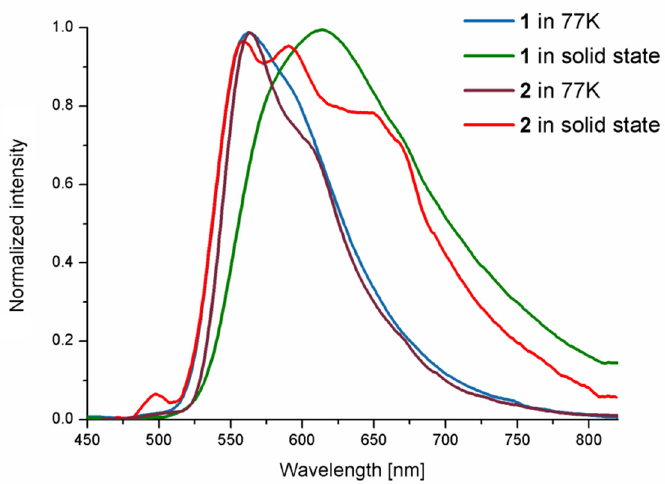
Figure 5. Normalized photoluminescence spectra of 1 and 2 in ethanol–methanol rigid-glass matrix (77 K) and solid state. Table 2. Relevant photophysical parameters of complexes 1 and 2 .